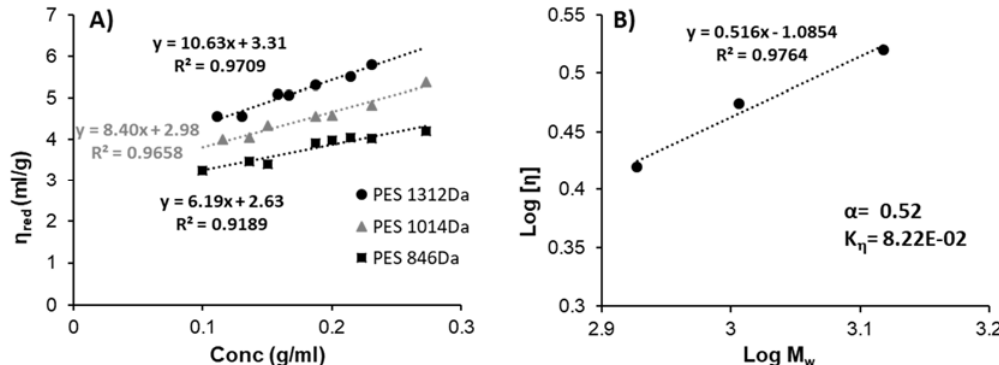
Figure 9. ( A ) The reduced viscosity as a function of PES with different molecular weights to determine the intrinsic viscosity, ( B ) The logarithm of intrinsic viscosity as a function of the logarithm of corresponding molecular weight to estimate the KMHS coefficient ( K η ) and exponent α .